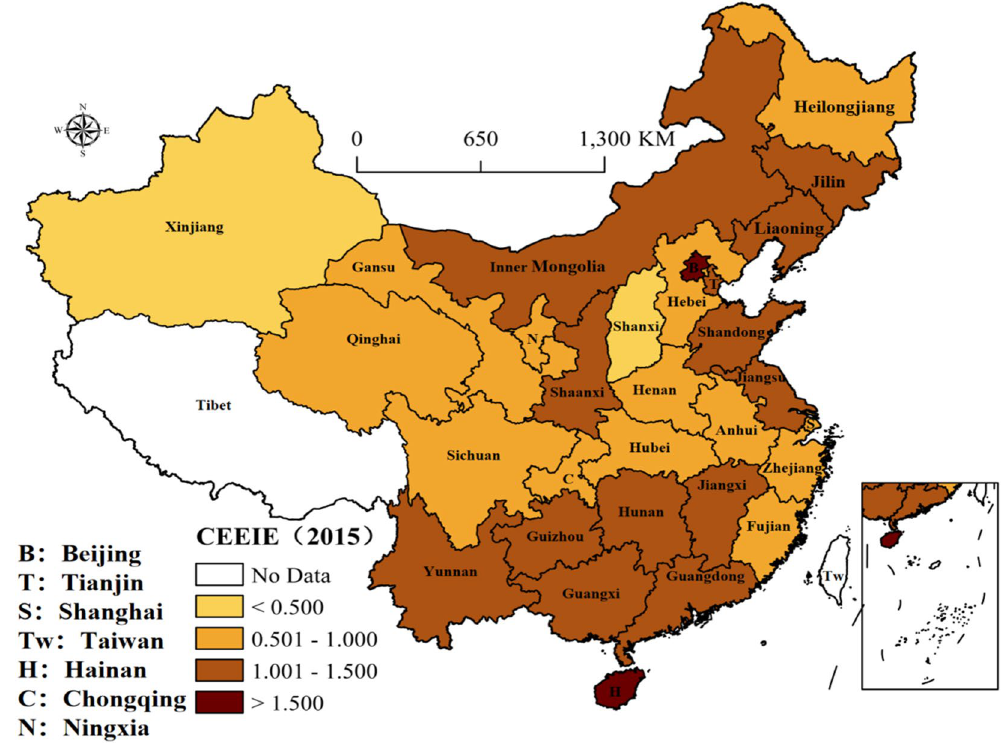
Figure 4. The distribution of CEEIE in 2015 (prepared by KL in ArcGIS Pro, https:// www. esri. com/ zh- cn/ arcgis/ produ cts/ arcgis- pro/ resou